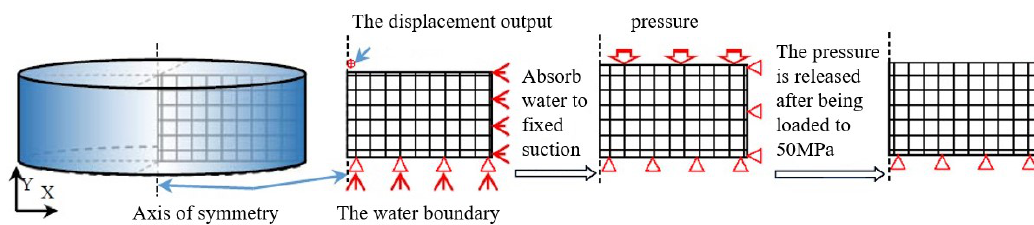
Figure 4. Numerical modeling approach of SO-01 in suction controlled compression.